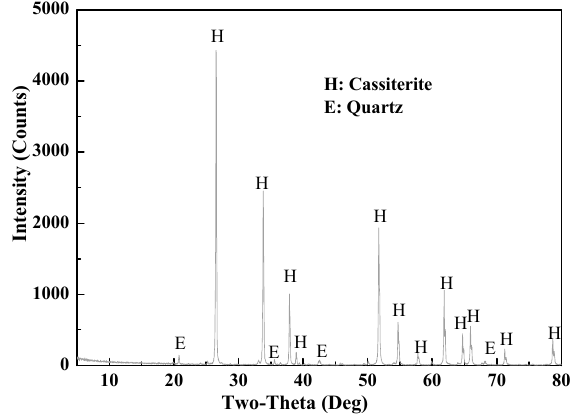
Figure 4. X-ray diffraction pattern of raw material. Figure 4. X-ray di ff raction pattern of raw